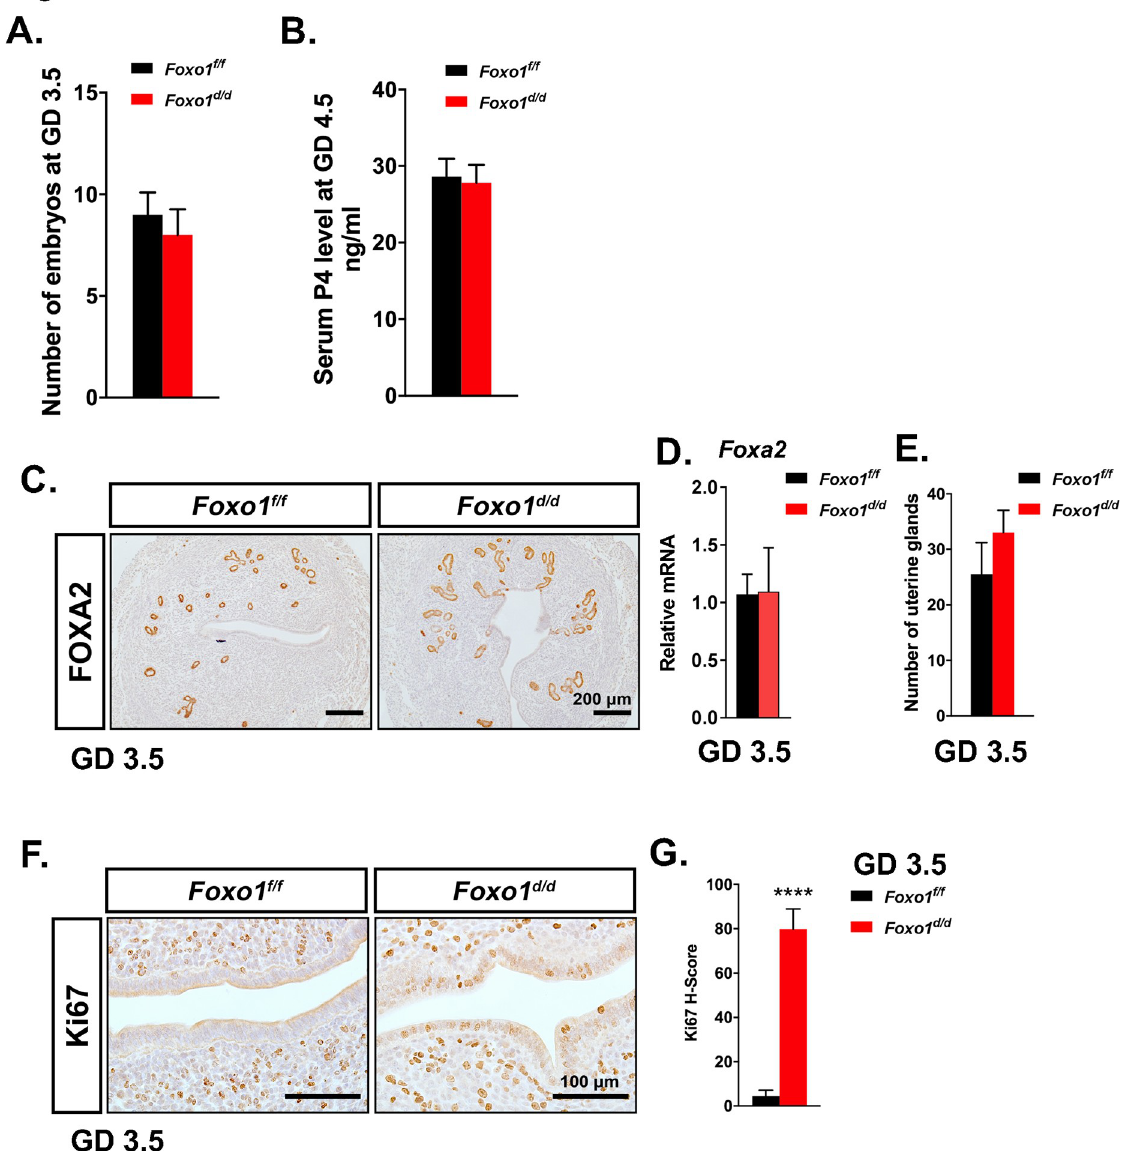
Fig 3. Ablation of Foxo1 causes continues proliferation in uterine epithelia independent of ovarian function and adenogenesis. (A) The number of embryos flushed from Foxo1 f/f and Foxo1 d/d uteri at GD 3.5 ( n = 5). (B) Serum P4 level from Foxo1 f/f and Foxo1 d/d mice at GD 3.5 ( n = 5). (C) Immunohistochemical staining of FOXA2 in GD 3.5 uteri from Foxo1 f/f and Foxo1 d/d mice ( n = 4). Scale bar, 200 μ m. (D) Quantification of Foxa2 gene in GD 3.5 uteri from Foxo1 f/f and Foxo1 d/d mice ( n = 6). (E) The number of uterine glands from Foxo1 f/f and Foxo1 d/d mice ( n = 4) at GD 3.5. (F) Immunohistochemical staining of Ki67 in GD 3.5 uteri from Foxo1 f/f and Foxo1 d/d mice ( n = 4). Scale bar, 100 μ m. (G) H-score quantification of Ki67 in endometrial section of Foxo1 f/f and Foxo1 d/d mice (n = 3) at GD 3.5. Data are presented as means ± SEM. ���� , P <